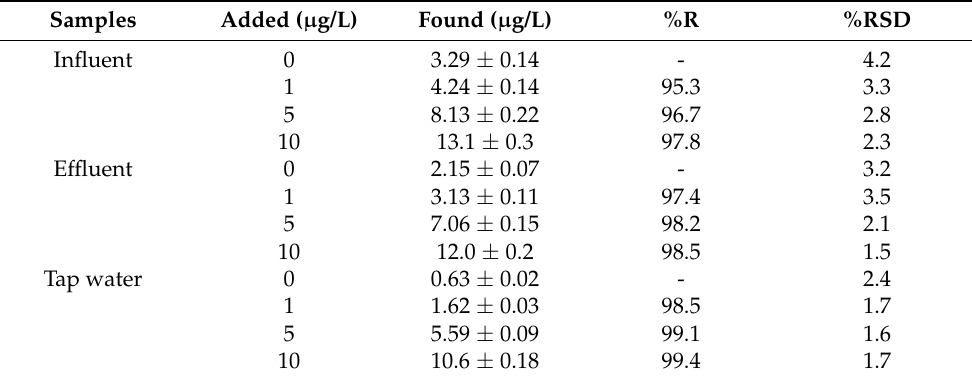
Table 10. Accuracy and precision of (VA-d- µ -MISPE) method for extraction and pre-concentration of ACT in real samples.